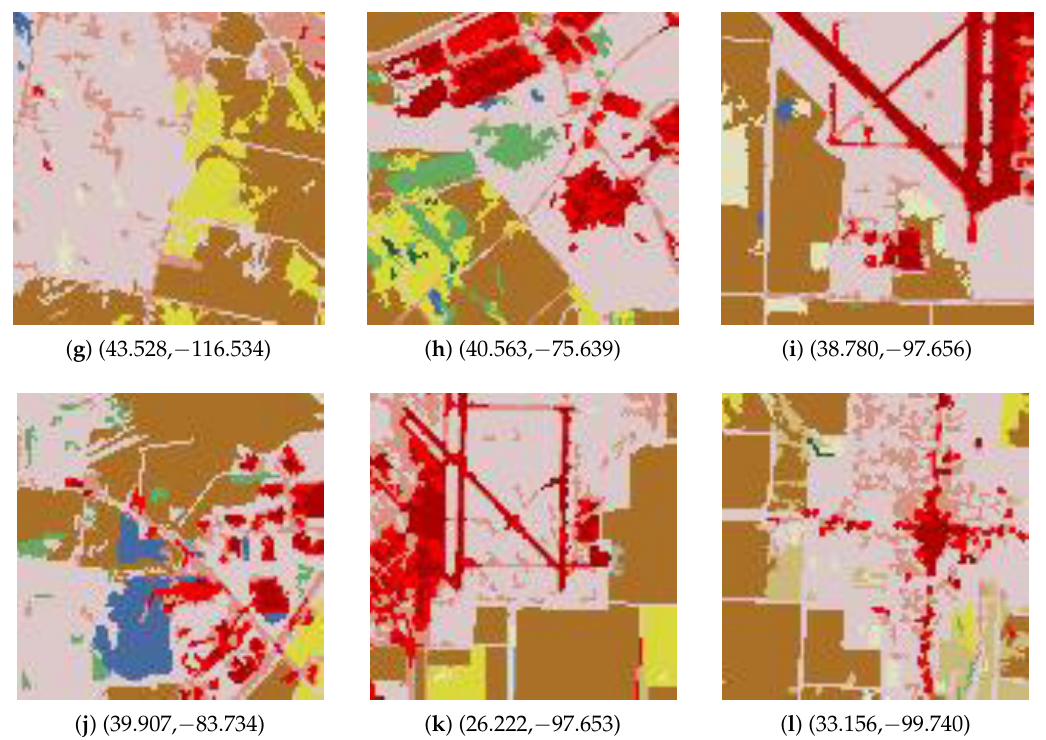
Figure 21. Top 12 scenes most similar to the reference scene (see Figure 21a) obtained by the proposed method. The content in the brackets is the geographic coordinates of the scenes.